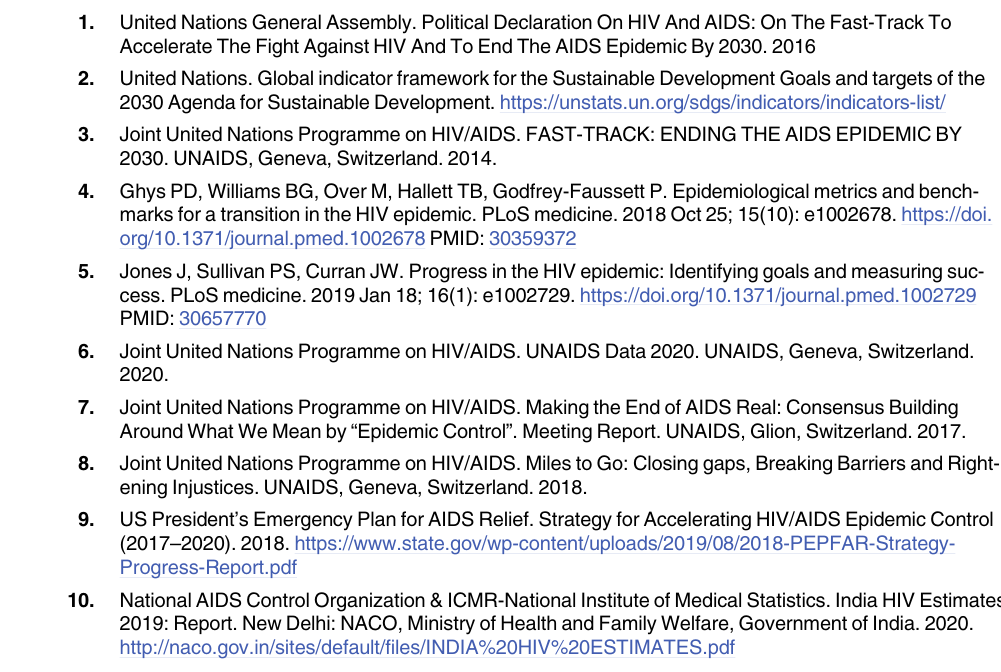
S2 Table. IPR and IMR by States/UT in India,